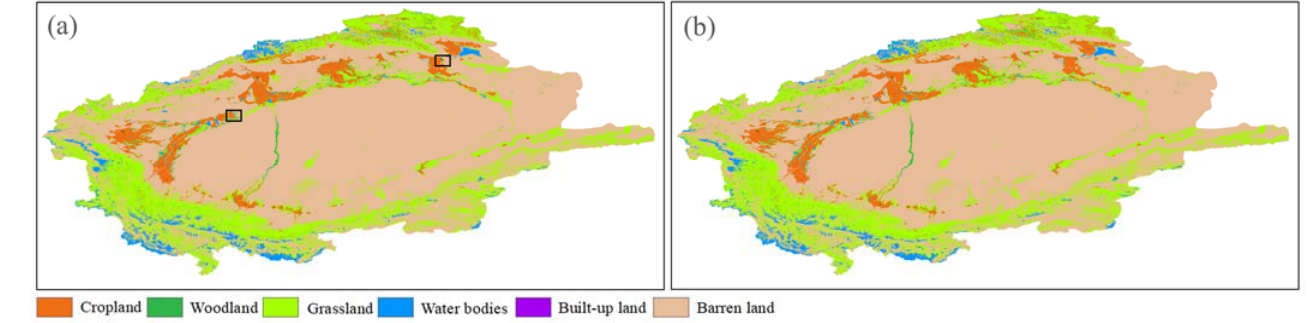
Figure 5. Map of simulated and actual land use change in the Tarim River Basin in 2015. ( a ) Actual land use data, ( b ) Simulation land use data.